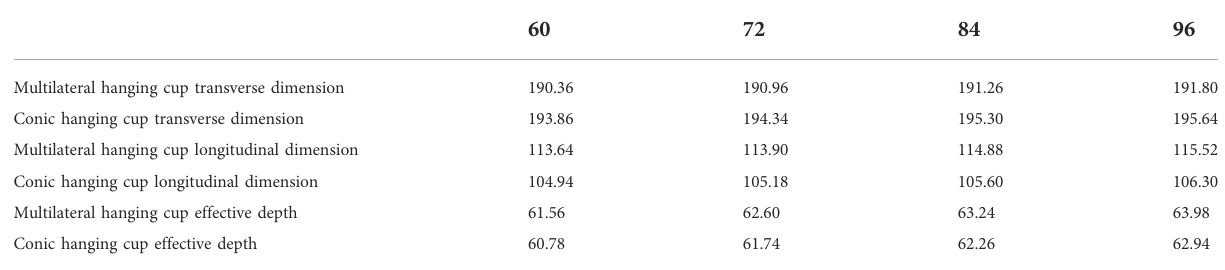
TABLE 9 Hole size for the hanging cup test.